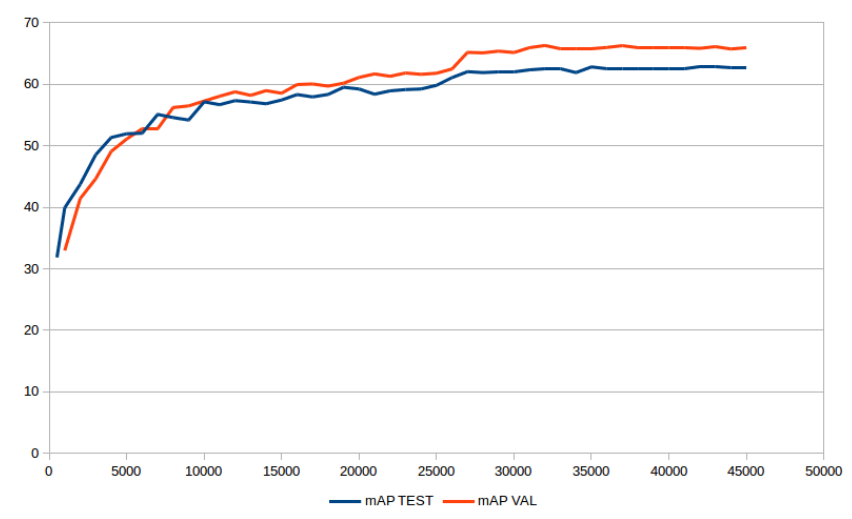
Figure 11. mAP for test and validation sets in YOLOV2 for 45,000 iterations.